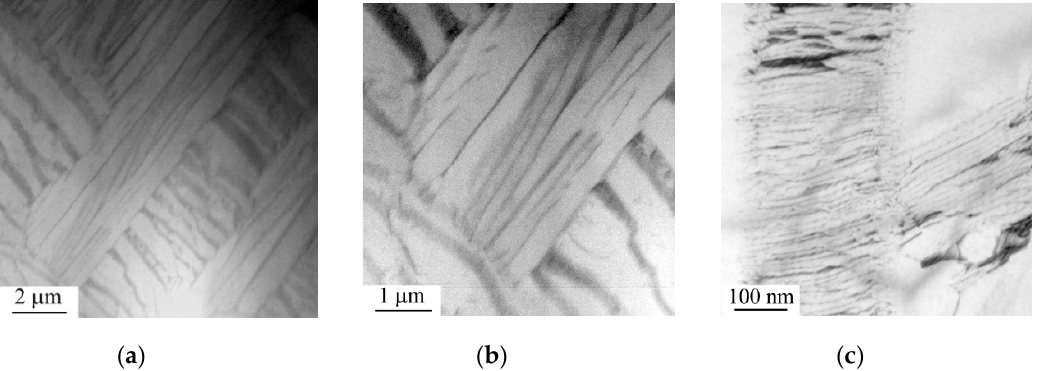
Figure 8. STEM ( a,b ) and TEM bright-field images ( c ) of the microstructures of the core of the EBF 3 -fabricated Ti–6Al–4V sample.